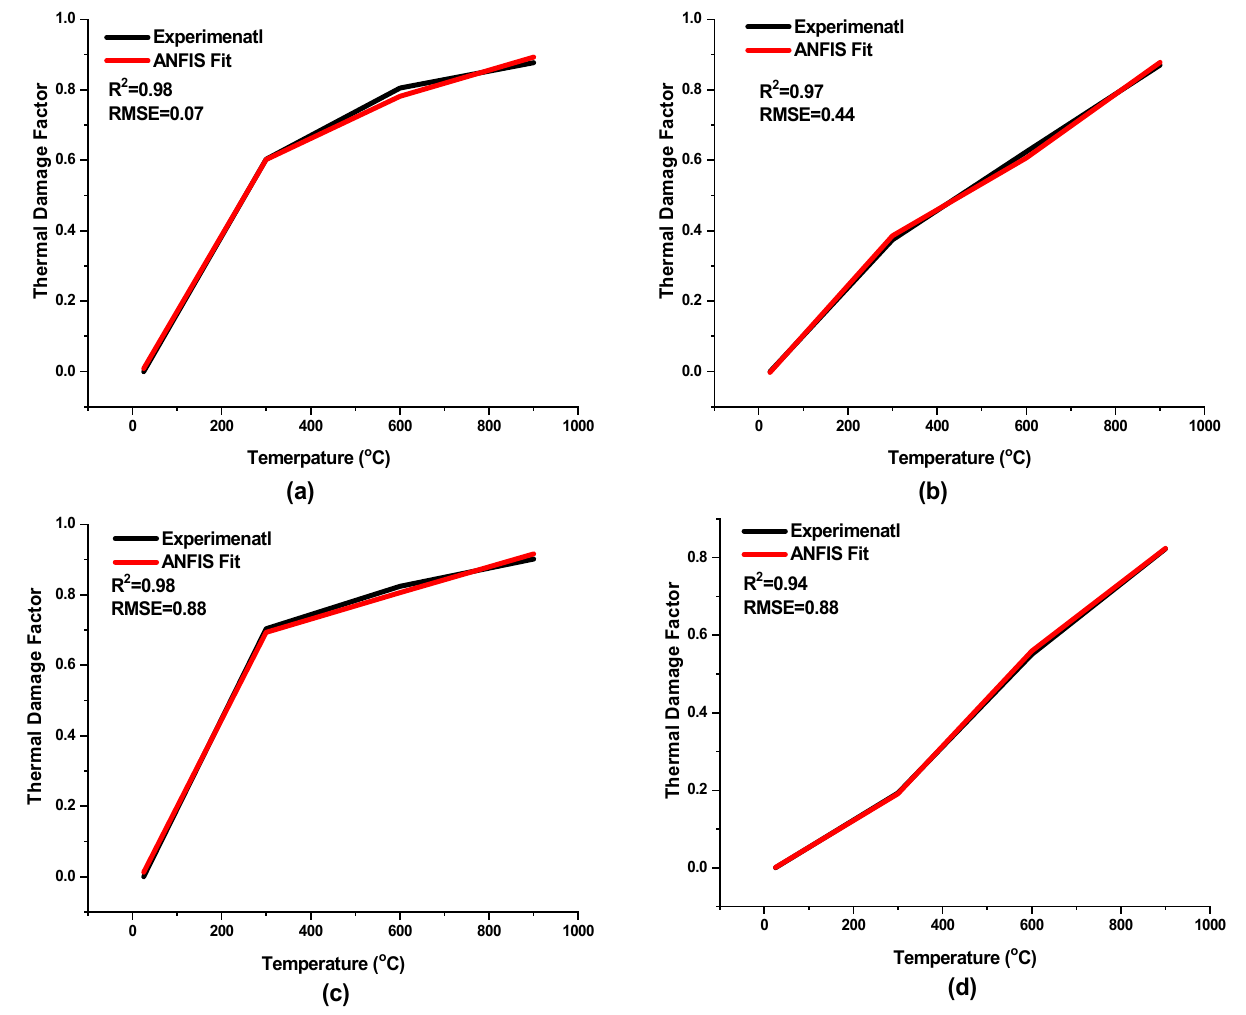
Figure 11. Experimental and ANFIS models; ( a ) porosity-based D T under slow cooling, ( b ) elasticity- based D T under slow cooling, ( c ) porosity-based D T under rapid cooling, and ( d ) elasticity-based D T under rapid cooling.